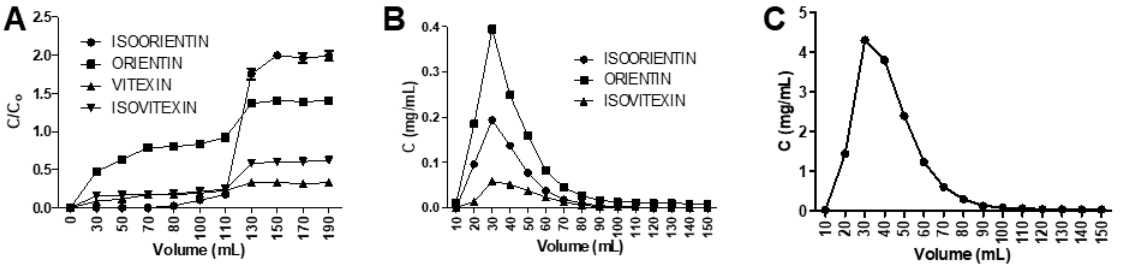
Figure 5. Dynamic breakthrough curves for flavonoid C -glycosides ( A ) and dynamic desorption curves for isoorientin, orientin, and isovitexin ( B ) and vitexin ( C ) in OPLAH on XAD7HP resin. Each value is the average reading from three replicates (n = 3).